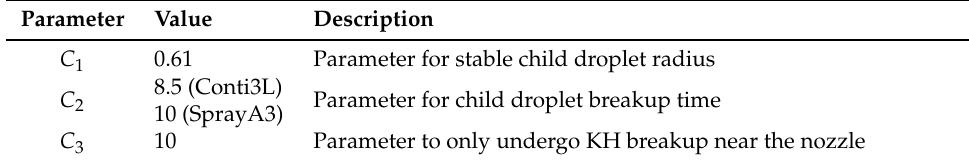
Table 7. KHRT breakup model